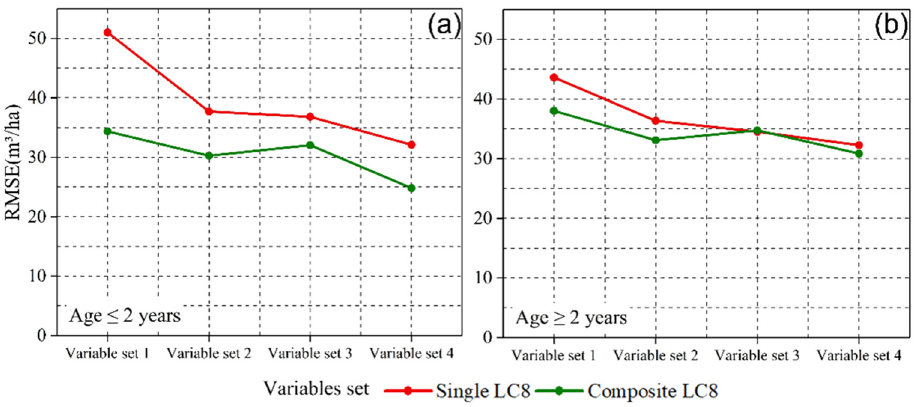
Figure 12. Contribution of crown width, forest height and stand age in mapping FSV: ( a ) indicates samples older than 2 years; ( b ) indicates samples younger than 2 years.